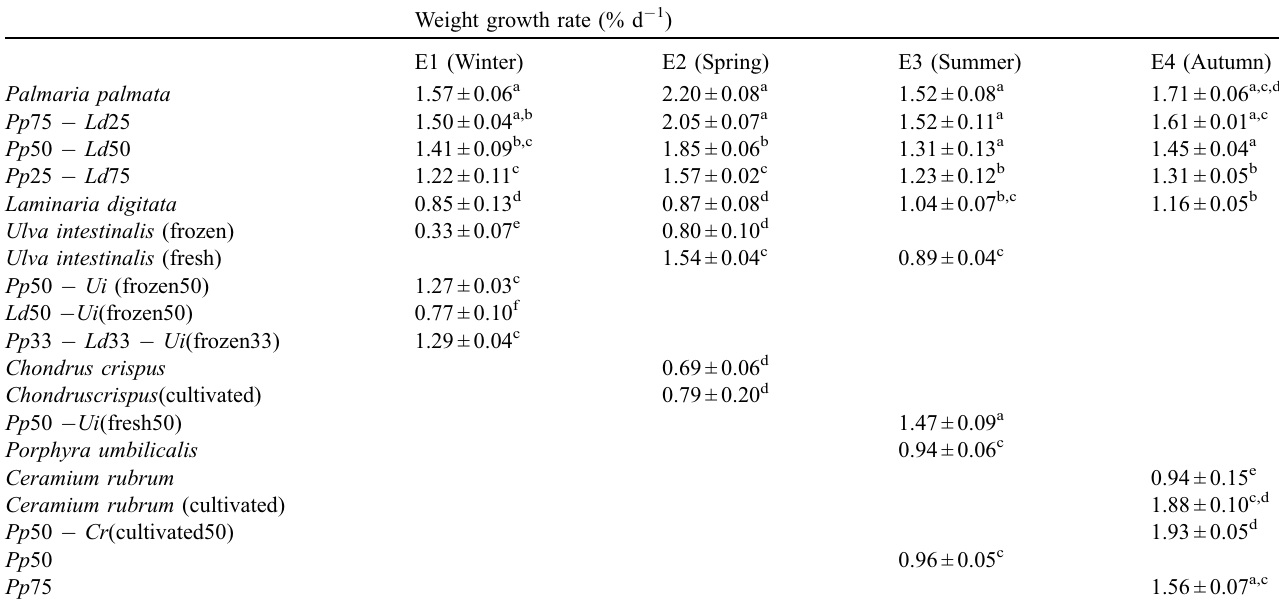
Table 5. Mean and con fi dence interval ( a = 0.05) of weight growth rates bytesting period: Pp : Palmaria palmata , Ld : Laminaria digitata , Ui : Ulva intestinalis , Cr : Ceramnium rubrum , Pp 25 (cid:3) Ld 75: a diet composed of 25% P. palmata and 75% L. digitata . Pp 75%: diet consisting of 75% of the amount of P. palmata consumed when supplied ad libitum . For each season, diets that do not share a letter signi fi cantly differ (ANOVA and SNK tests, p < 0.05).